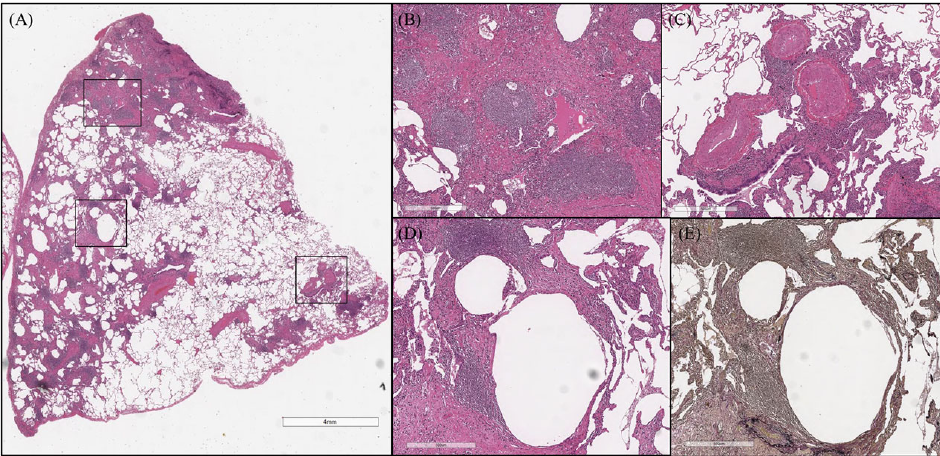
Figure 4. Surgical lung biopsy of case presentation (Case 8). In fl ammatory cell in fi ltration and lym-